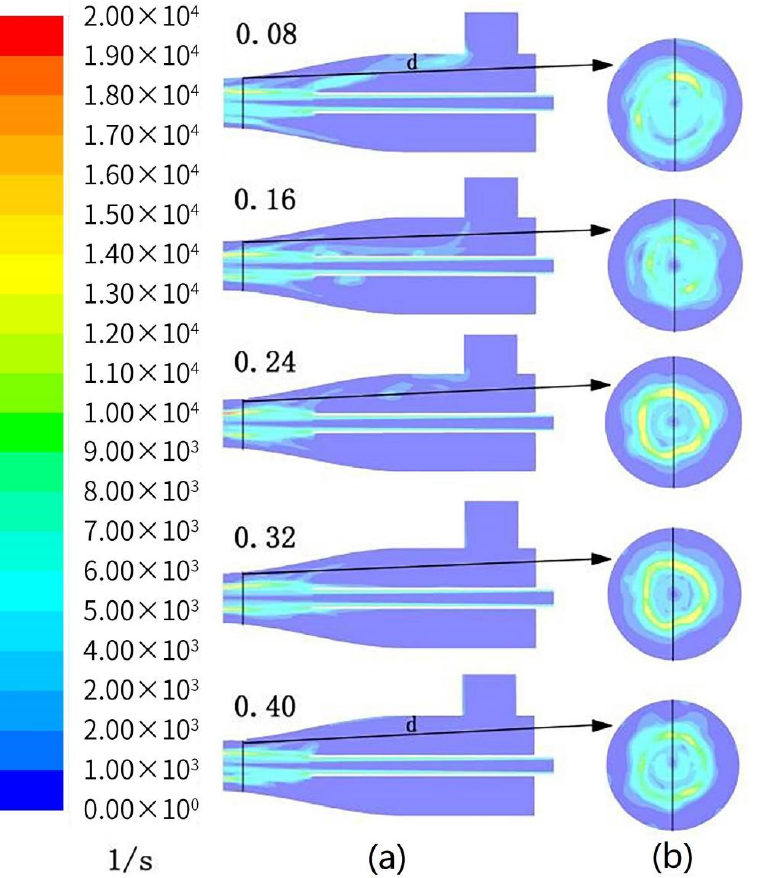
Figure 10. Distribution diagram of vorticity magnitude with different gas–liquid ratios. ( a ) Distribution of vorticity magnitude on plane Y = 0. ( b ) Distribution of vorticity magnitude on cross–section X = 0.065 m.